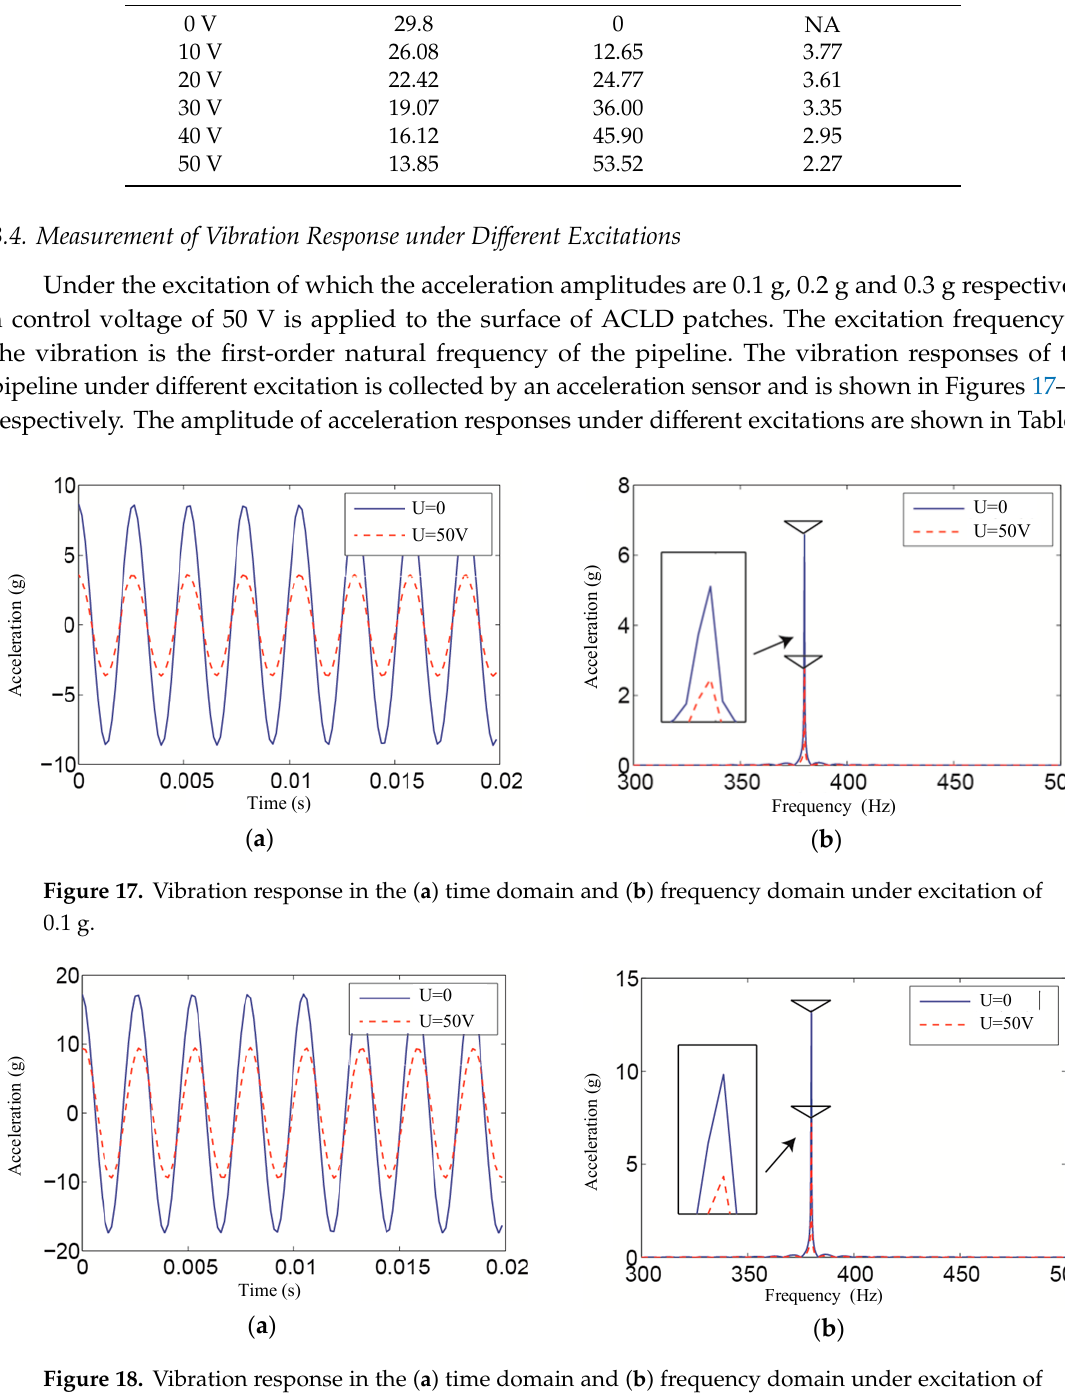
Figure 18. Vibration response in the ( a ) time domain and ( b ) frequency domain under excitation of 0.2 g.